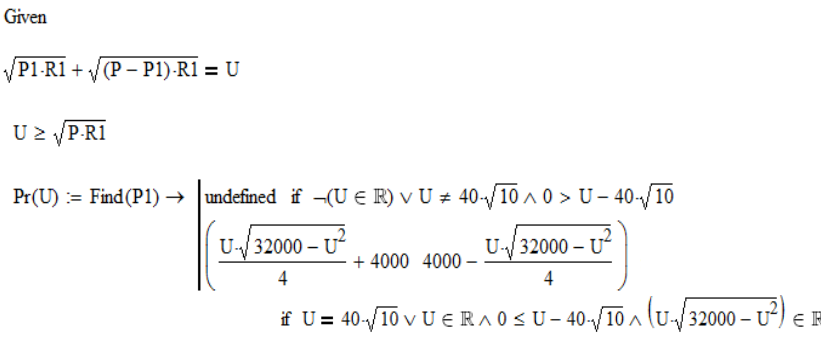
Figure 12. Listing of the program for the symbolic solution of system (15).